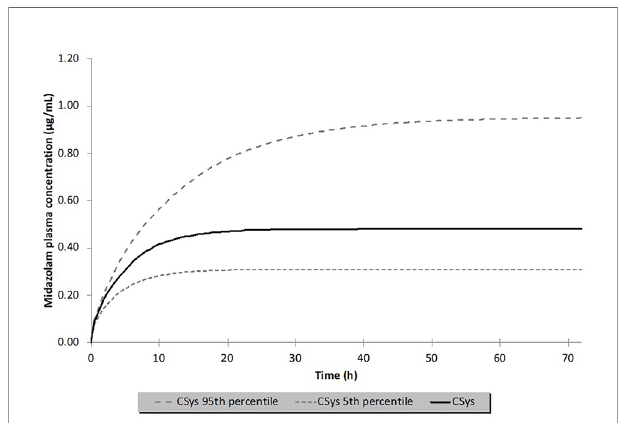
FIGURE 6 | Output of a sensitivity analysis for midazolam clearance (CL) in neonates, illustrating the model-predicted impact of changes in unbound fraction in plasma (fu_plasma) assuming a fi xed blood/plasma ratio (B/P ratio) of 0.55. A sensitivity analysis for the B/P ratio between 0.55 and 1.2 did not reveal any signi fi cant changes in hepatic CL. During normothermia, the reported fu value is 0.04.